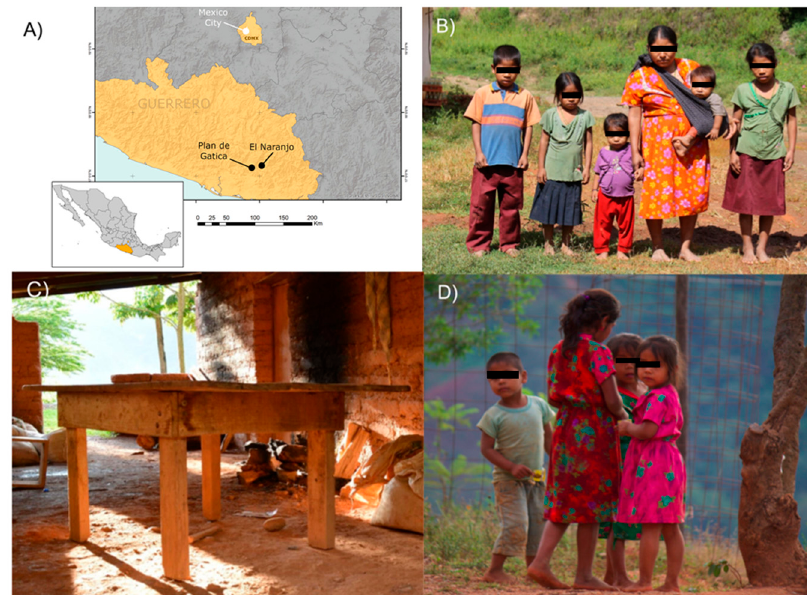
Figure 1. Maps of sample populations and lifestyle conditions in the Me’phaa population. ( A ) Sampling locations for this study. Map displaying the geographical locations taking as reference the south-central region of M é xico in the state of Guerrero (black points) and M é xico City (white point); ( B ) A representative Indigenous family from the Me’phaa community sampled; ( C ) The typical house construction observed in Me’phaa community; ( D ) Males and females children from 5 to 8 years old. Photos by